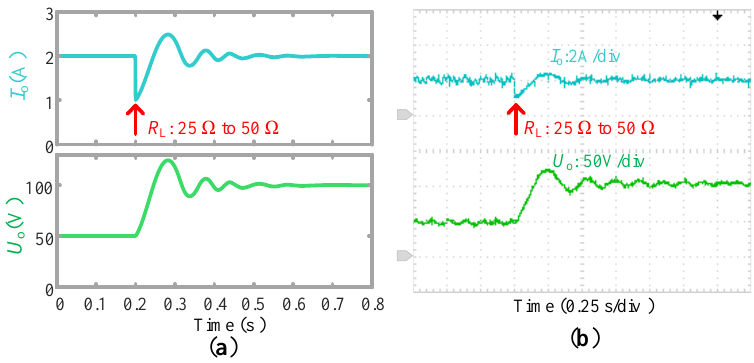
Figure 11. Simulated and experimental CC power transfer results of DPC system: ( a ) simulated; and ( b ) experimental. I o , output current (blue lines); U o , output voltage (green lines). Figure 12a,b shows the simulated and experimental CV power transfer results by DPC.